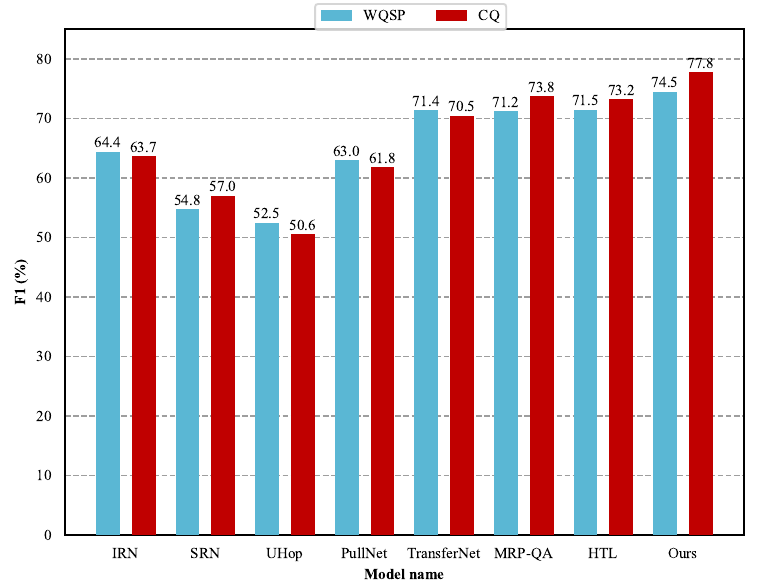
Figure 6. Performance of each model on the test